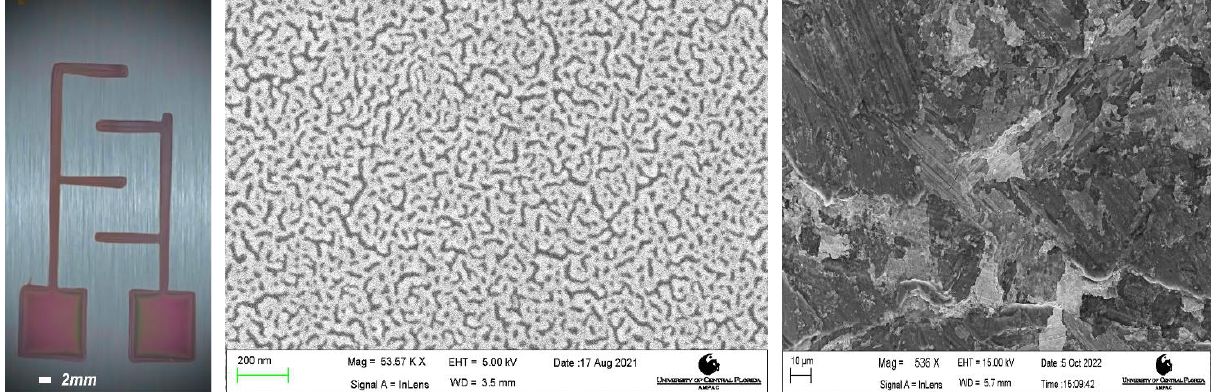
Figure 9. Deposition of a PECVD; ( Left ) Dielectric Interdigitated electrode, ( Center ) Deposition at 300 ° C and ( Right ) Deposition at 50 ° C.